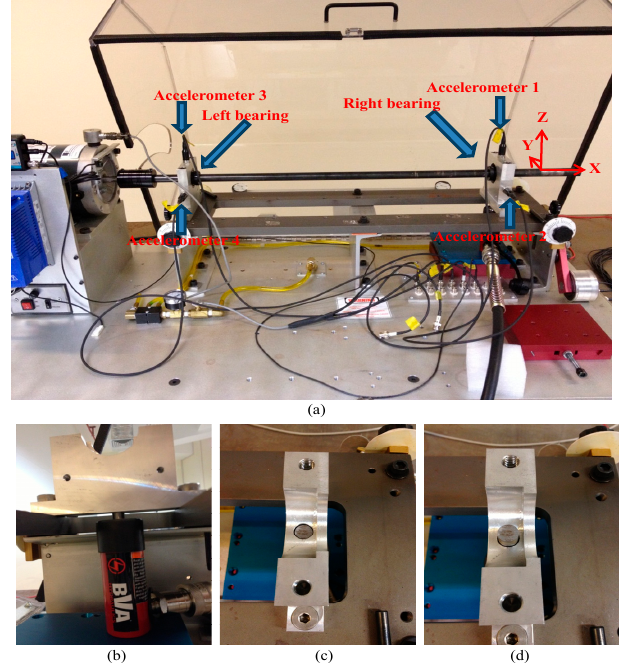
Figure 2. The experiment setup: ( a ) the locations of four accelerometers; ( b ) the application of the hydraulic jack to the outer race of the bearing; ( c ) the hydraulic jack without touching the surface of the bearing; and ( d ) the hydraulic jack applied to the surface of the outer race.